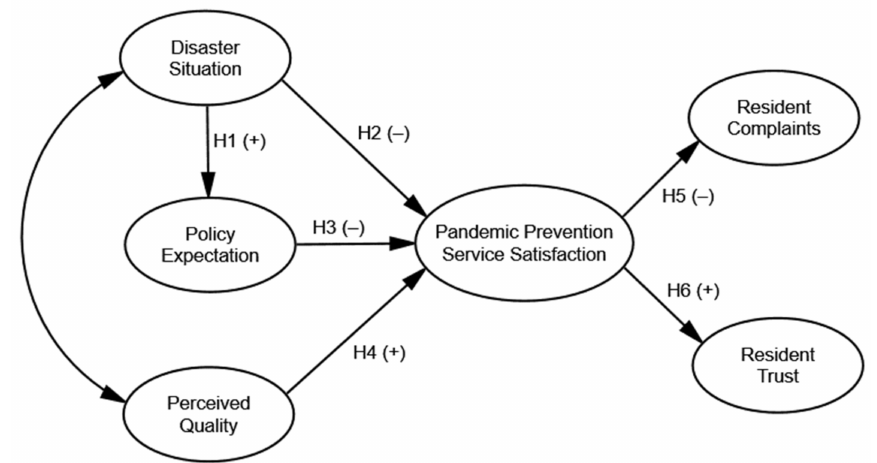
Figure 1. The theoretical